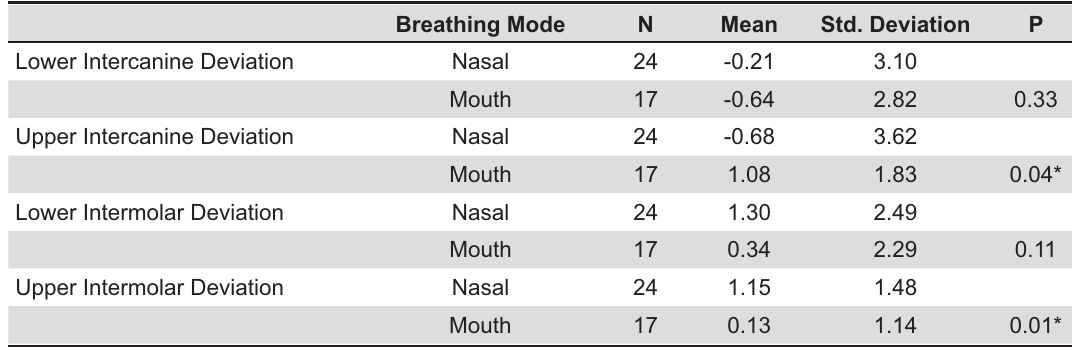
Table 2- Deviation comparison according to breathing mode